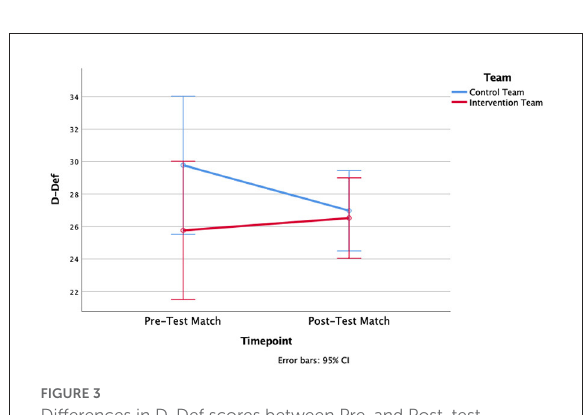
FIGURE3 Differences in D-Def scores between Pre-and Post-test matches for the Control Team and the Intervention Team.